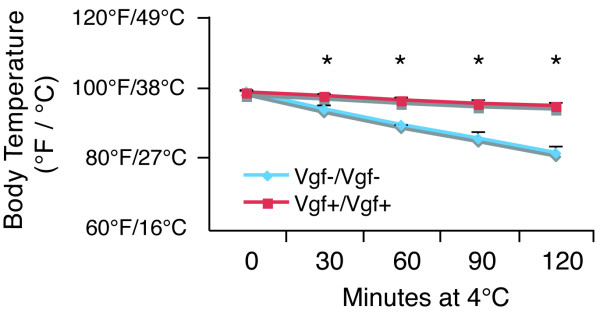
VGF-deficient mice have increased sensitivity to cold exposure. VgfC57 -/- and VgfC57 +/+ mice were placed at 4°C for 2 hours and allowed adlib access to food and water. Mice were individually housed and rectal temperatures were taken every 30 minutes. Body temperatures that are marked with an asterix from mutant (n = 2) and wild-type mice (n = 5) are significantly different from each other (ANOVA; p < 0.05; mean ± SEM).